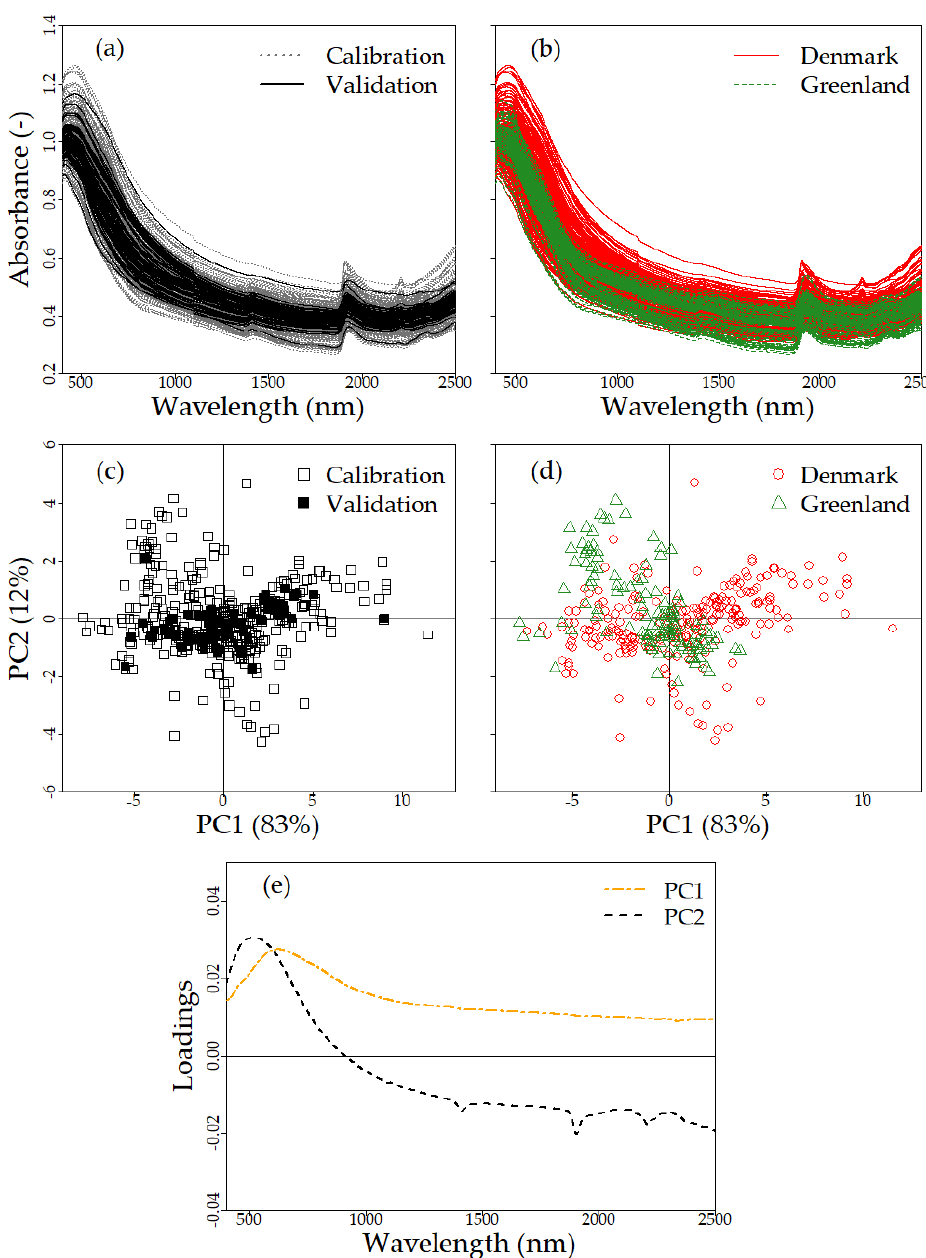
Figure 3. Spectral response for ( a ) the calibration and validation subsets of the combined dataset and ( b ) the Danish and Greenlandic datasets; score plots for ( c ) the calibration and validation subsets of the combined dataset and ( d ) the Danish and Greenlandic datasets; and ( e ) loadings plot for all soil samples.